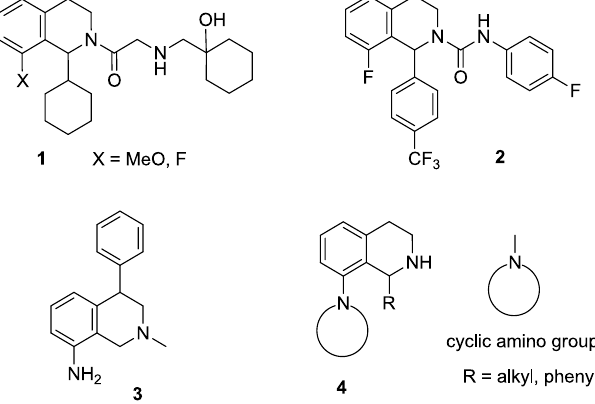
Figure 1. 1,8-Disubstituted tetrahydroisoquinoline target compounds ( 4 ) and their closest analogies ( 1 – 3 ) from the medicinal chemistry literature.